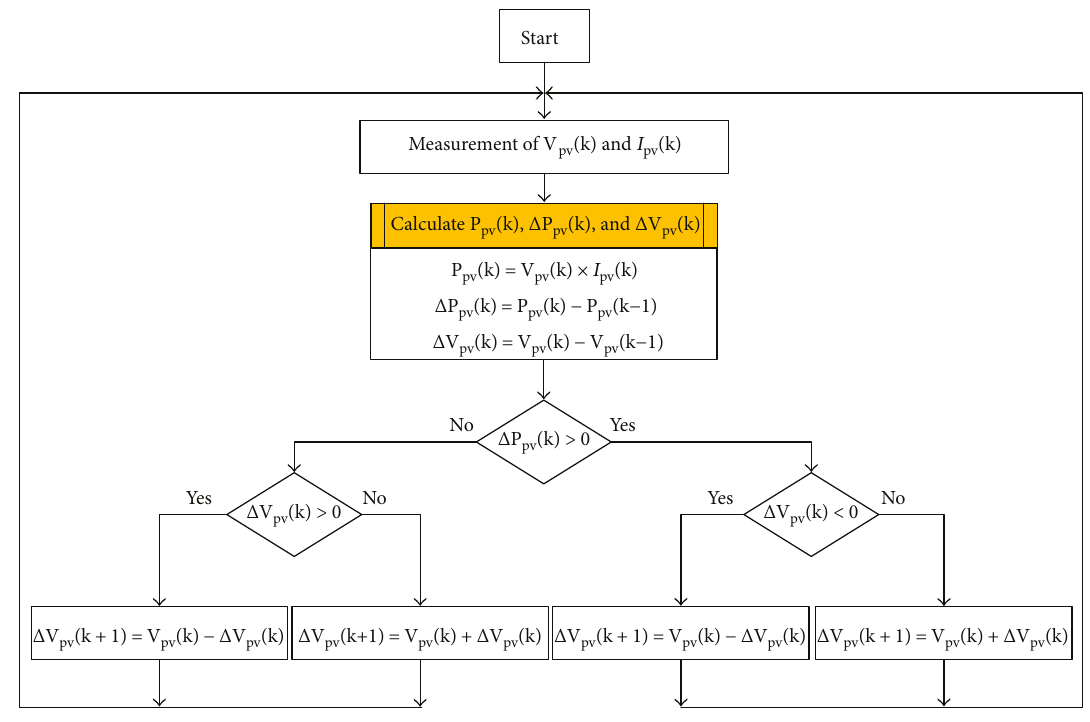
Figure 6: Flowchart for P&O MPPT method.